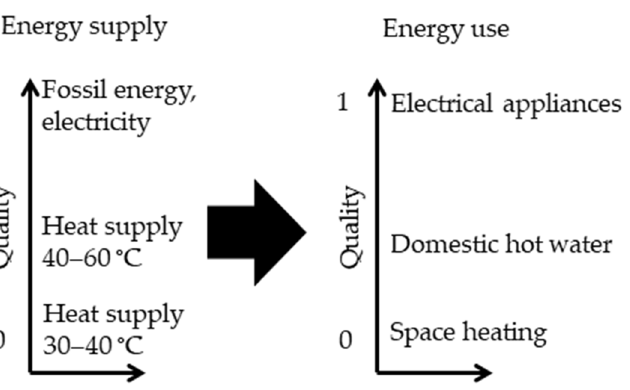
Figure 2. Optimal matching of the supply and demand quality levels in the building environment. Figure is adapted from [3].